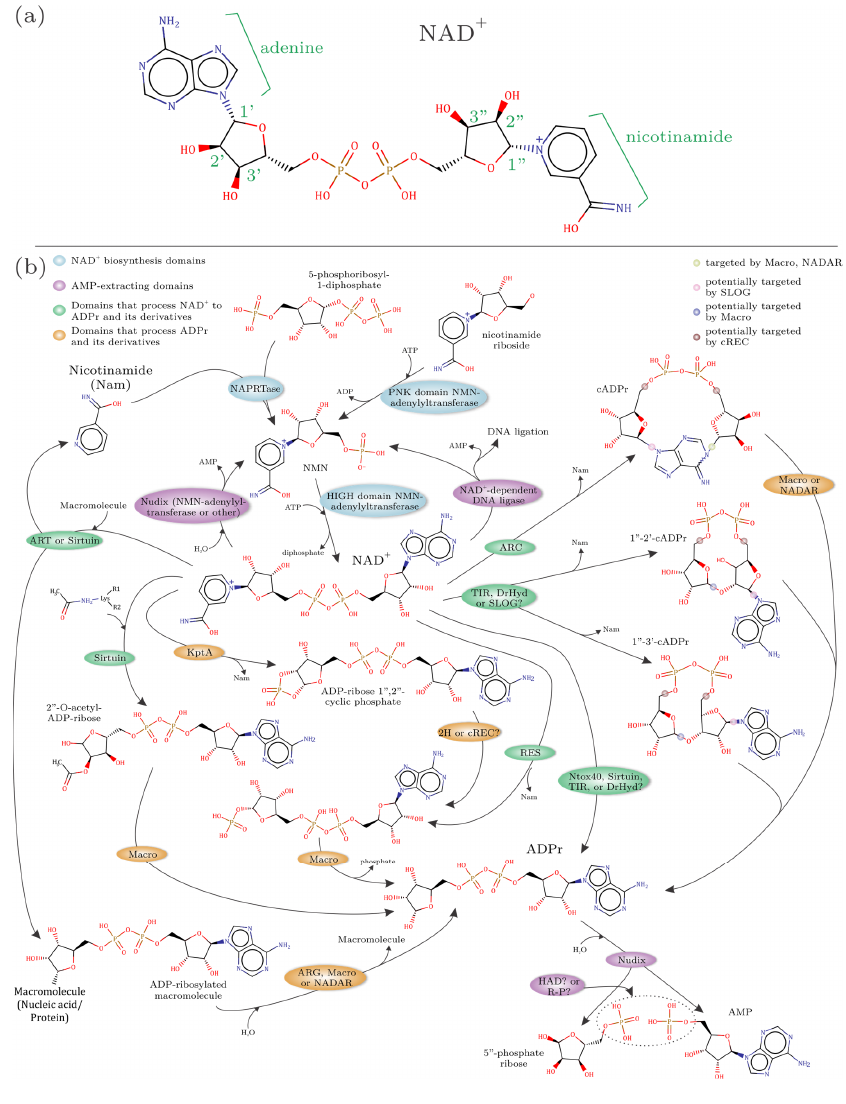
Figure 1. ( a ) Structure of NAD + and ( b ) the substrates and products of various enzymes in the NAD + –ADPr network. Enzymes are color-coded based on the pathway in which they are involved. Bonds that are the target of particular enzymes are highlighted with colored circles.